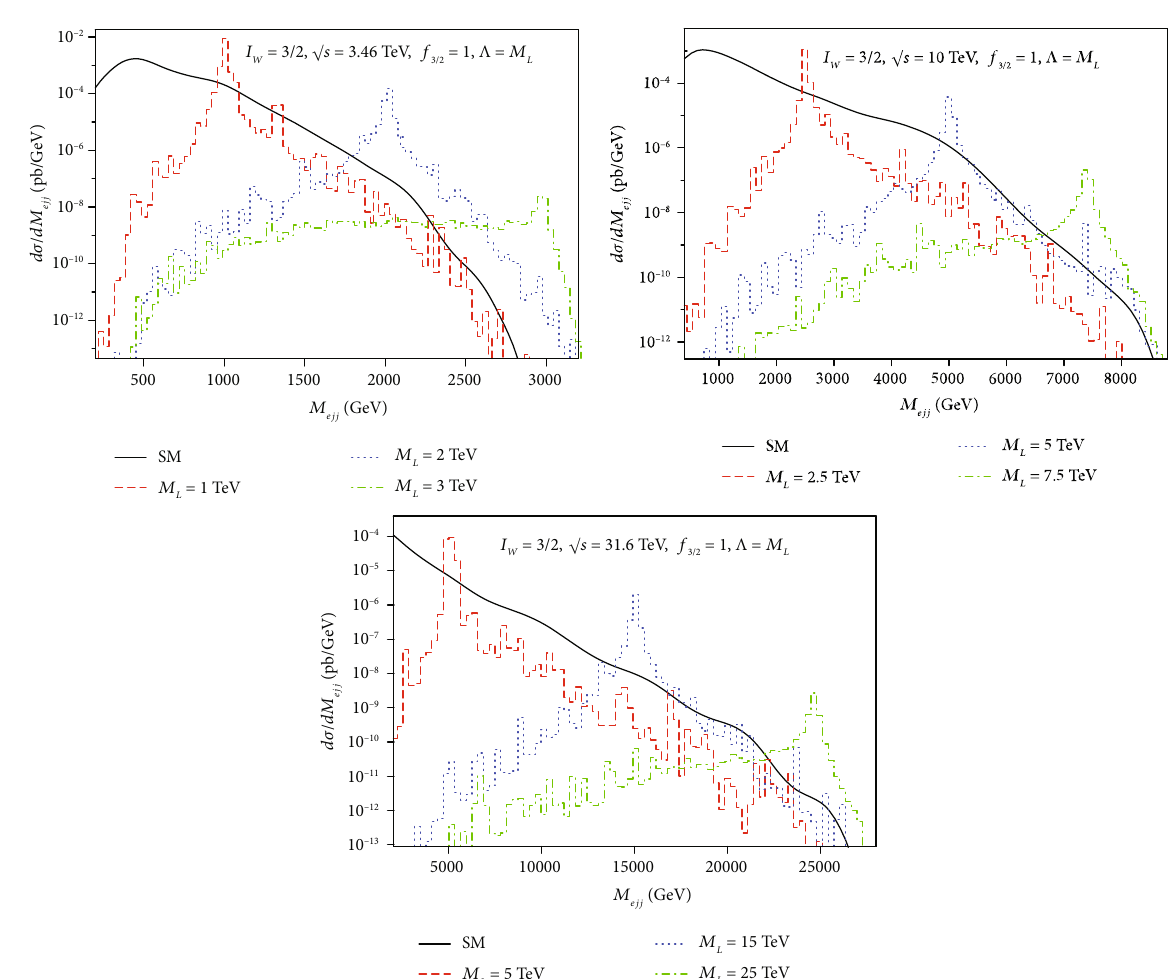
Figure 9: Invariant mass distribution of ejj system for I